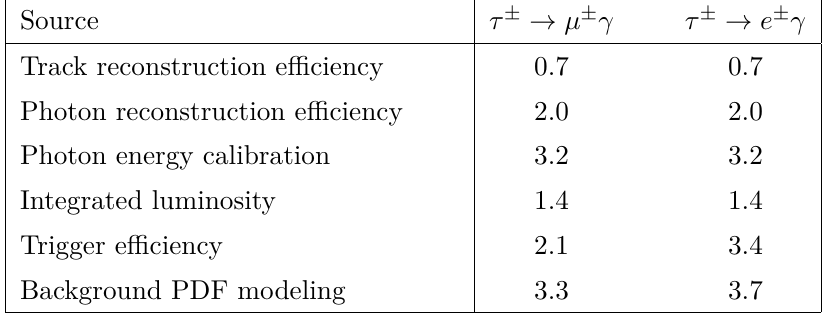
Table 1 . Systematic uncertainties (in % ) considered in this